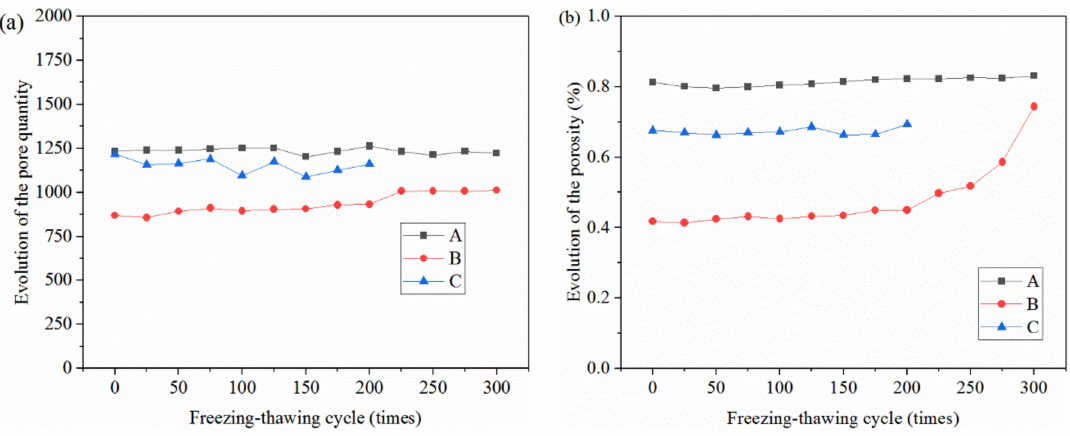
Figure 10. Evolutionary rules of pore quantity and porosity of concrete: ( a ) pore quantity; ( b )